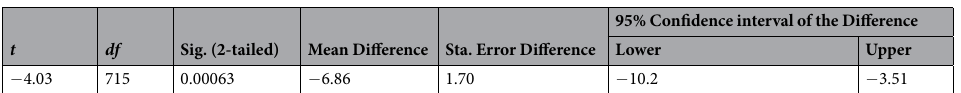
Figure 3 shows hourly 3-year average O 3 concentrations during 2013–2015. Ground-level O 3 concentrations showed a typical diurnal cycle with a minimum in the morning and a maximum in the afternoon. In the densely populated region, the maximum and minimum values of 3-year hourly averaged ground-level O 3 concentrations